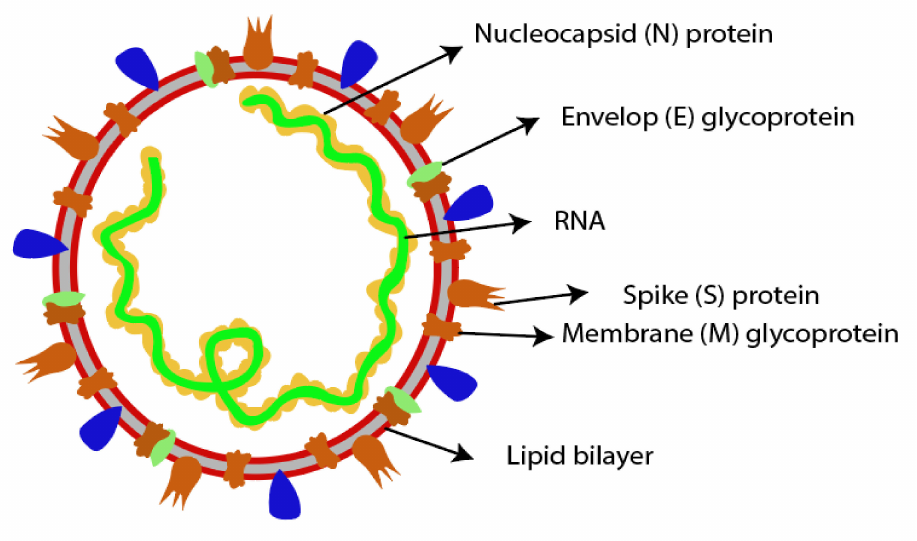
Figure 2. Representative structure of human